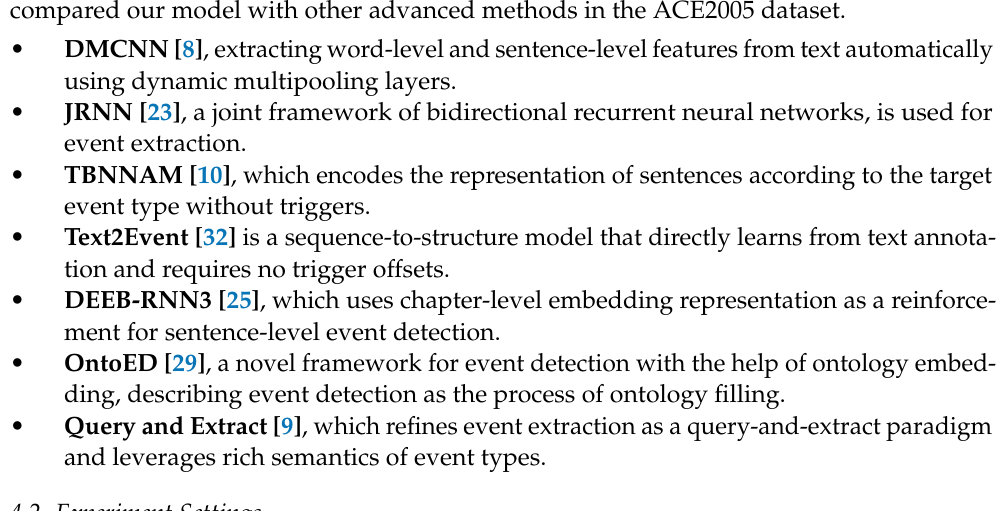
Table 3. Examples of annotated instances. Sentences Labels Armored forces destroyed dozens of Iraqi tanks and personnel carriers in their advance on Baghdad. They got married in